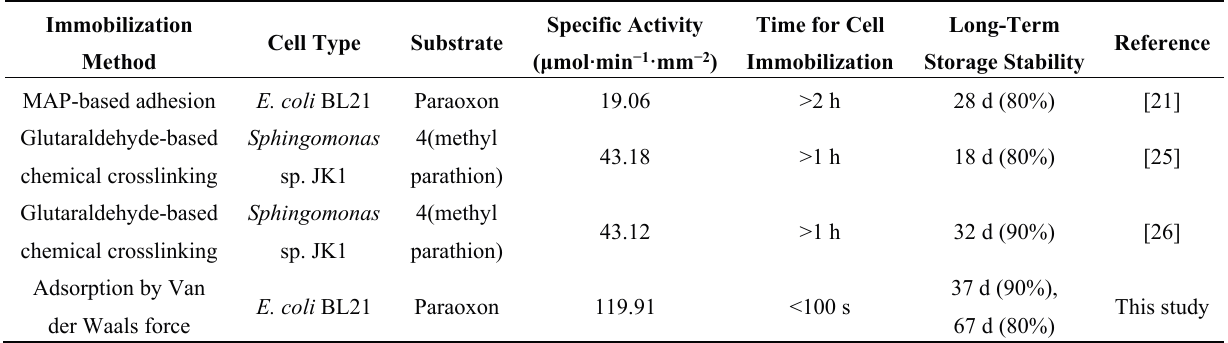
Table 1. Characteristic comparison between this study and other whole-cell based OP